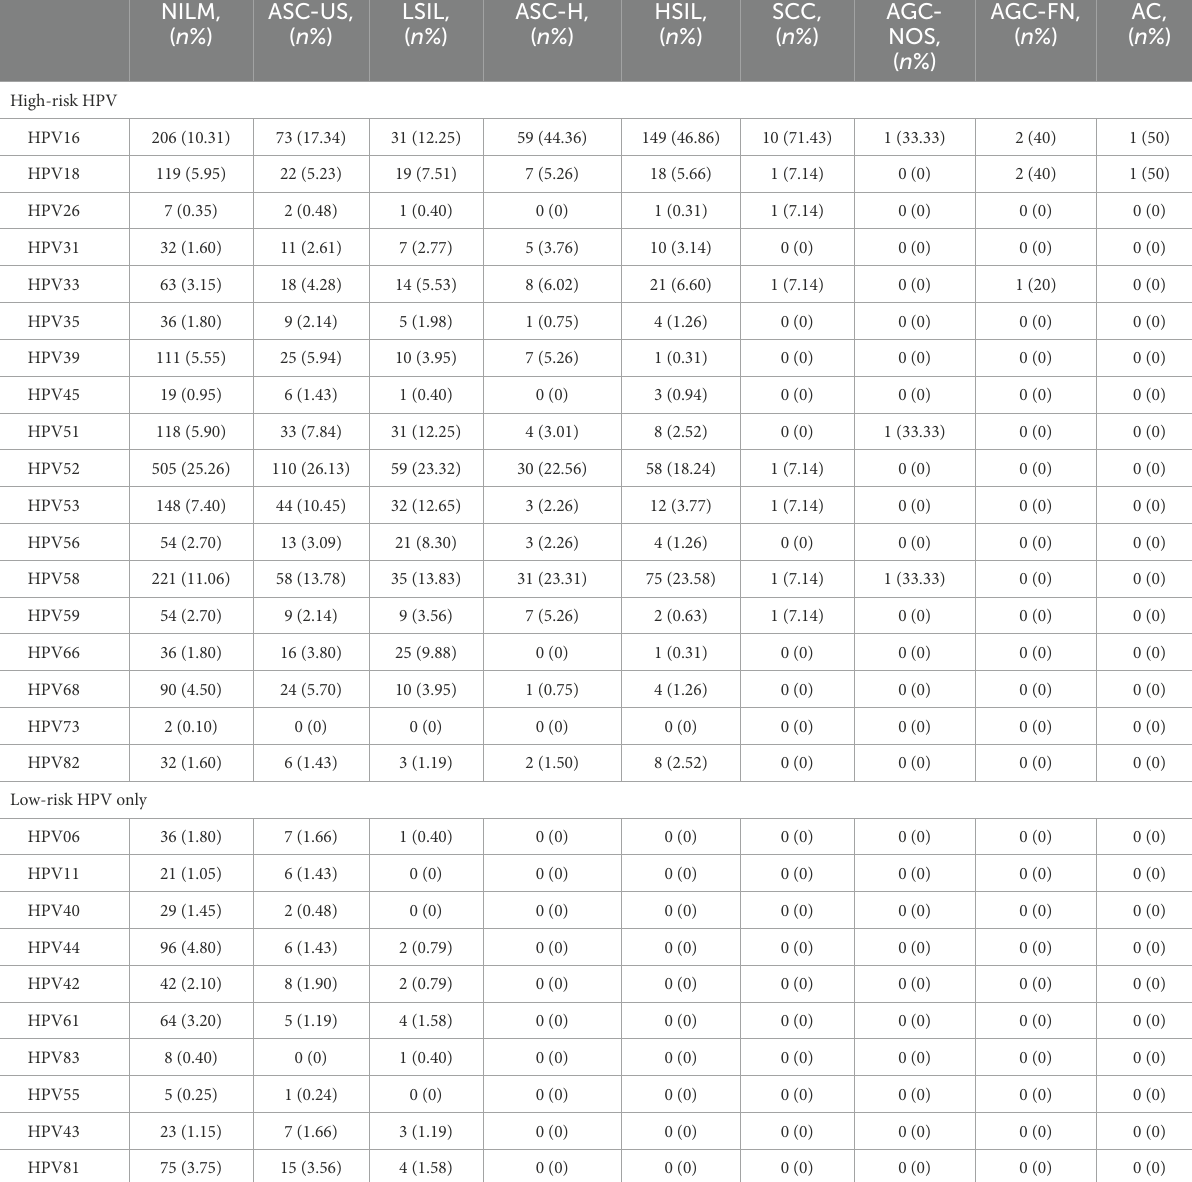
TABLE 4 Distribution of HPV genotypes in different cytology